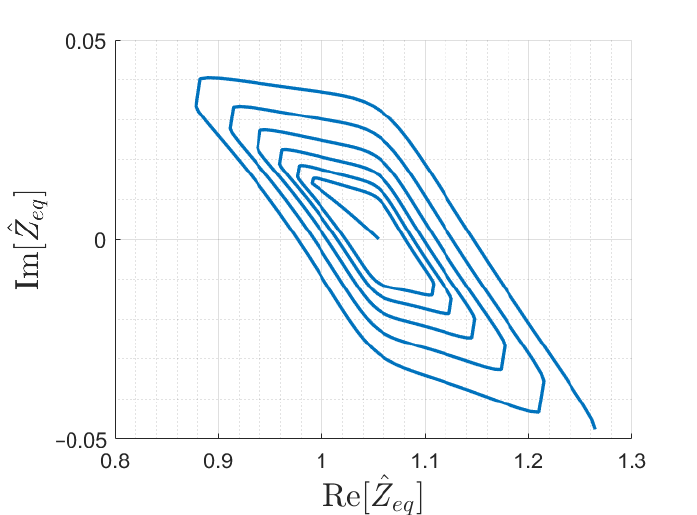
Figure 12. Input impedance trajectory as a function of the receiver position for the resonator array with twelve cells series-compensated receiver, terminated with ˆ Z T 1 =